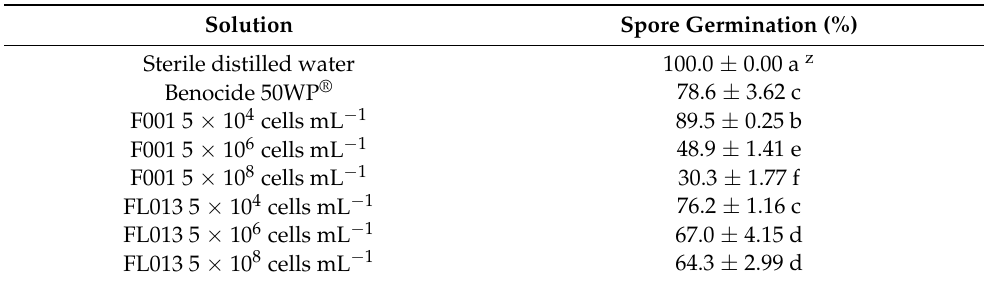
Table 4. Effects of different solutions on spore germination percentage of C. gloeosporioides after 20 h incubation at 28 ◦ C in PDB.